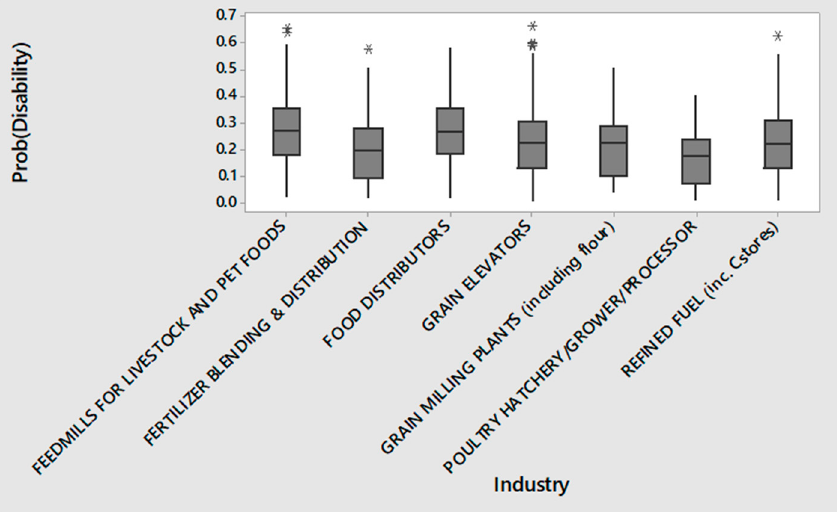
Figure 4. Boxplot of disability post-incident state with respect to industry. (* shows the outlier data points).